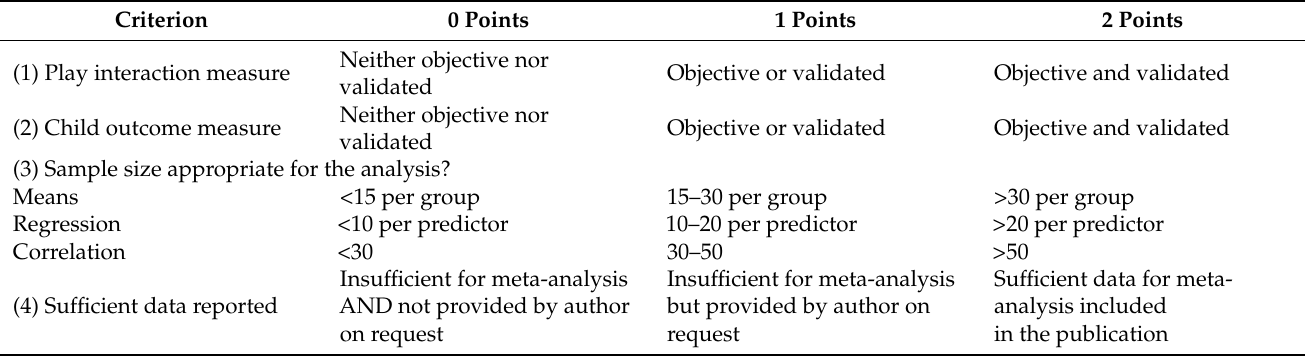
Table 1. Point allocations for study quality